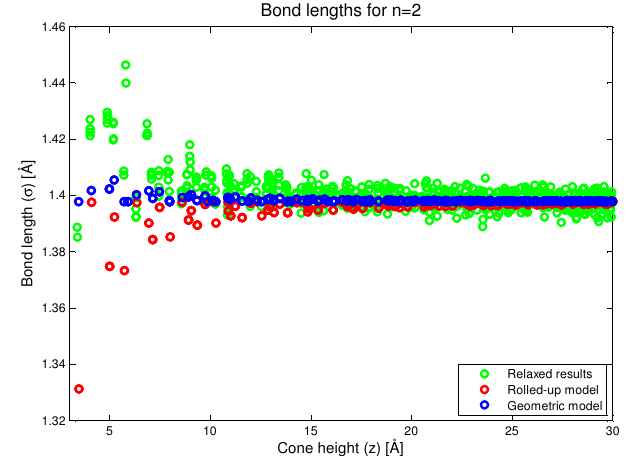
Figure 6. Bond lengths as predicted by the rolled-up, new geometric and simulation methods.